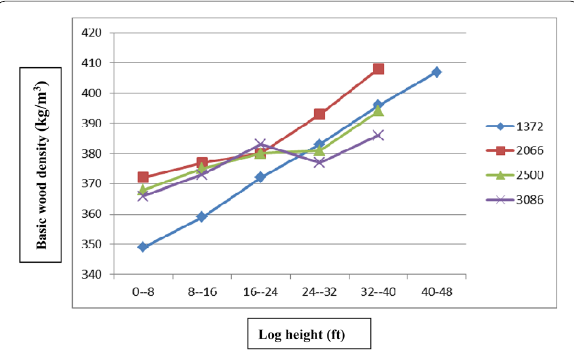
Fig. 2 Basic wood density in relation to stand density and log height